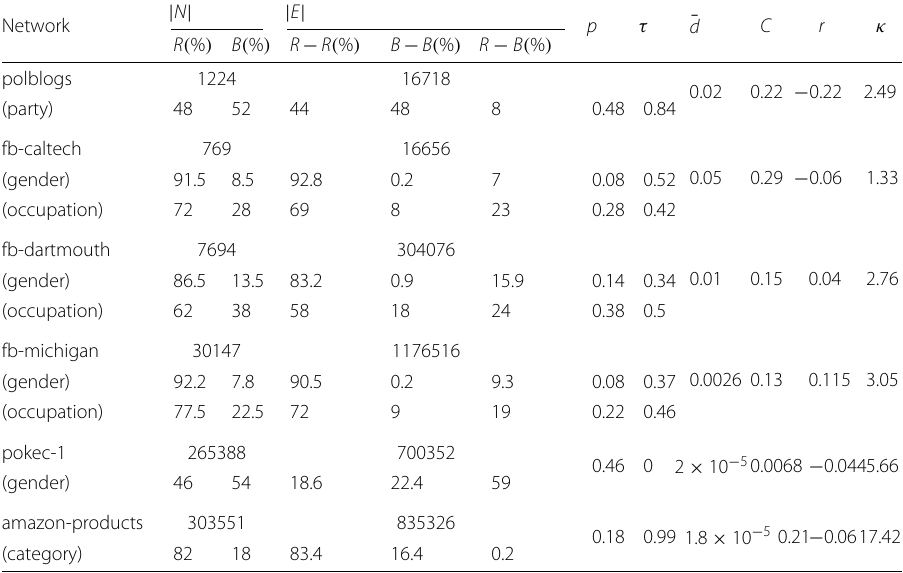
Table 1 Graph properties of the real network datasets